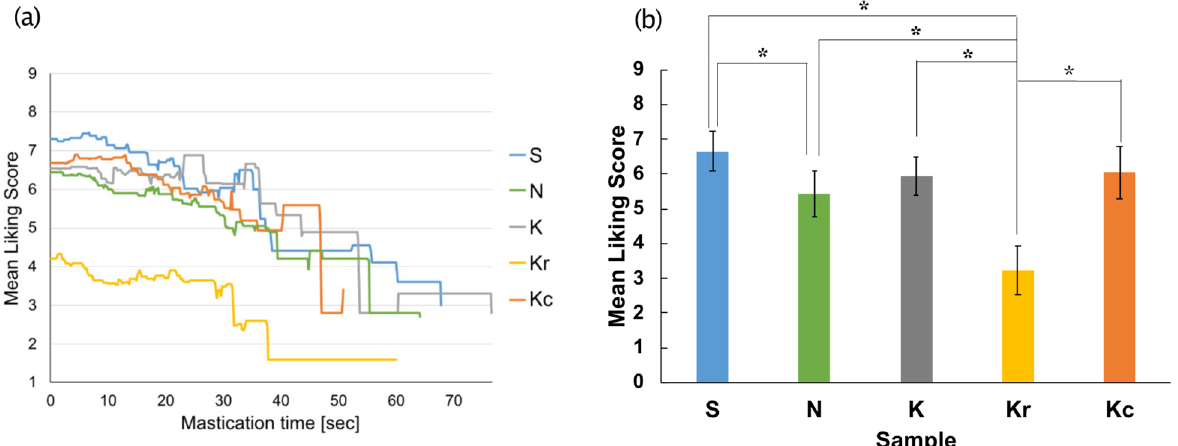
Figure 4. The results of the liking session in Experiment 1. ( a ) Temporal changes in the liking score for each sample. ( b ) Average liking score for each sample. * p < 0.05. Samples S, K, and N are available commercially and produced by different manufactures. Sample Kc was a crushed version of K, and Kr was a moisturized and re-dried version of K.